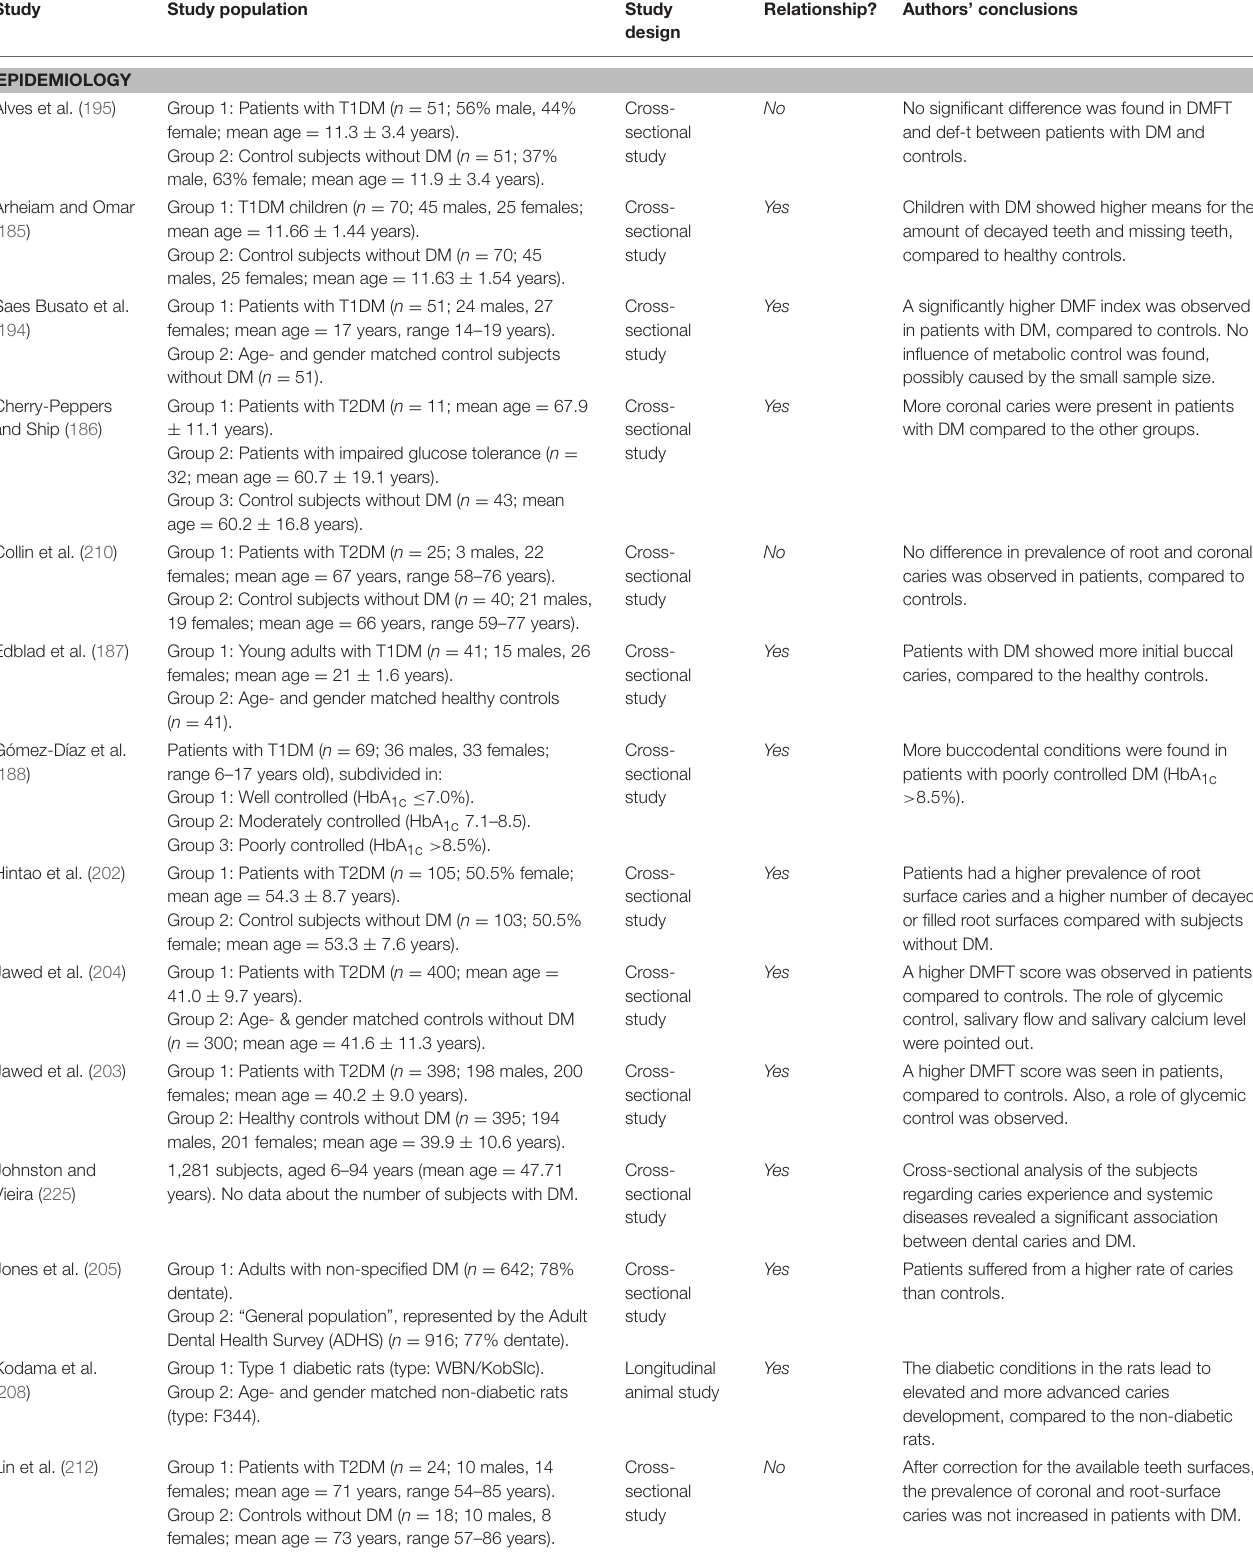
No After correction for the available teeth surfaces, Cross- the prevalence of coronal and root-surface sectional caries was not increased in patients with study